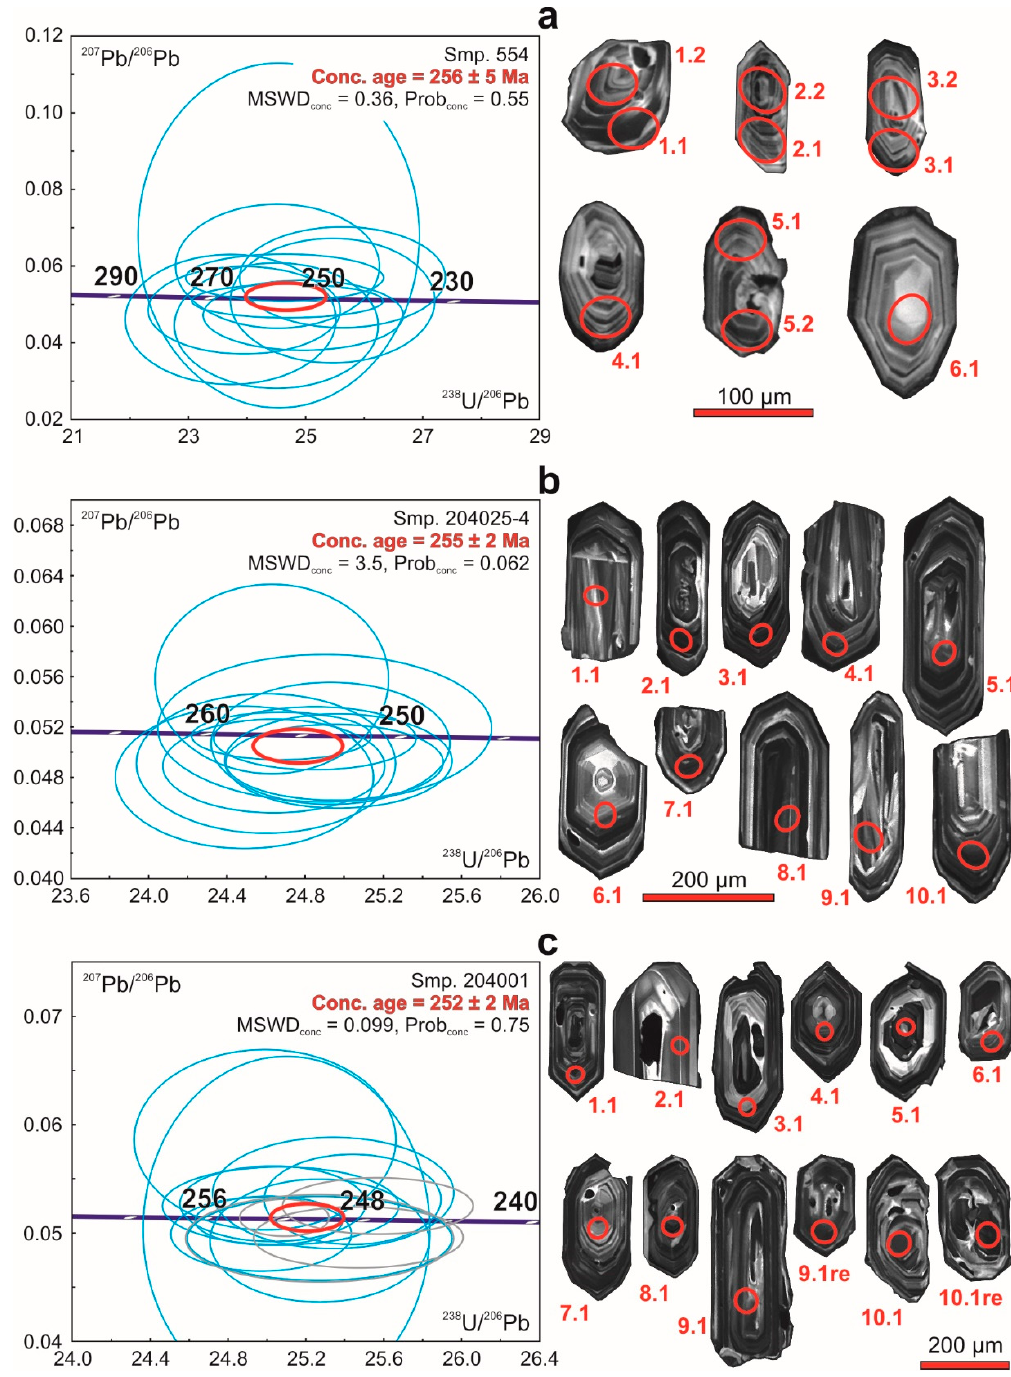
Figure 15. Concordia diagrams and CL zircon images for samples of postcollisional granitoids of the Kara orogen: sample 554 ( a ), sample 204025-4 ( b ), sample 204001 ( c ). Data-point error ellipses are 2s; decay-const. errs included.